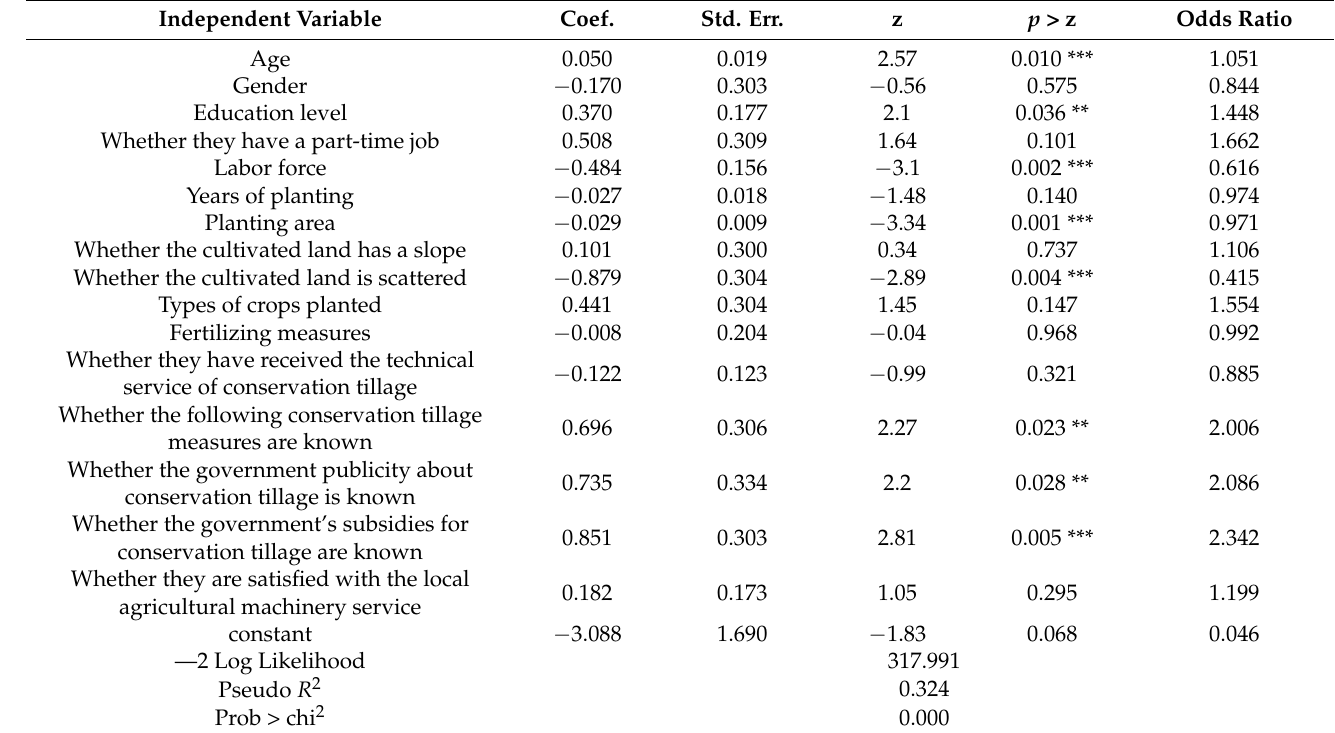
Table 2. Results of the regression